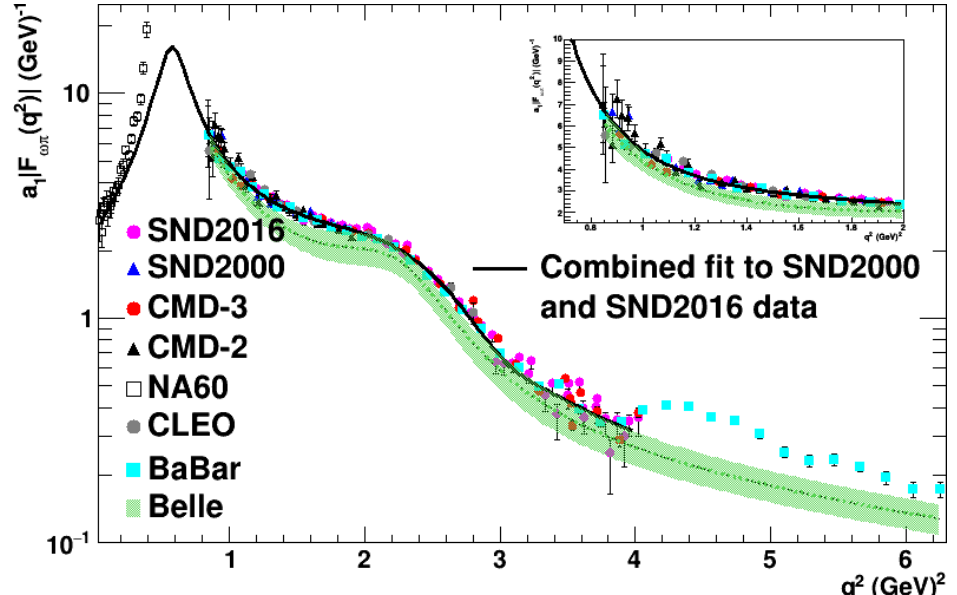
Figure 2 . (color online). The !(cid:25) production form factor weighted by the value of a 1 with a 1 = 1 : 02 (cid:6) 0 : 02 [13] and shown in a log scale. The points with error bars show e + e (cid:0) data by the SND in ref. [14] (blue triangles, SND2000) and ref. [15] (magenta circles, SND2016), CMD-3 in ref. [19] (red circles), CMD-2 in ref. [18] (black triangles) and BaBar collaborations in ref. [20] (cyan squares) as well as ! conversion data by the NA60 in ref. [9] (open squares) and (cid:28) lepton data by the CLEO collaborations in ref. [17] (grey circles). The black solid line is the combined (cid:12)t result to the SND2000 and SND2016 data taken from ref. [15]. The green dotted line corresponds to the p function a 1 = 2 j F B ( q 2 ) j . The green dashed area represents the 68% con(cid:12)dence level contour of !(cid:25) statistical uncertainties of the model parameters in eq. (2.1). The zoomed-in plot in the low q 2 region is also